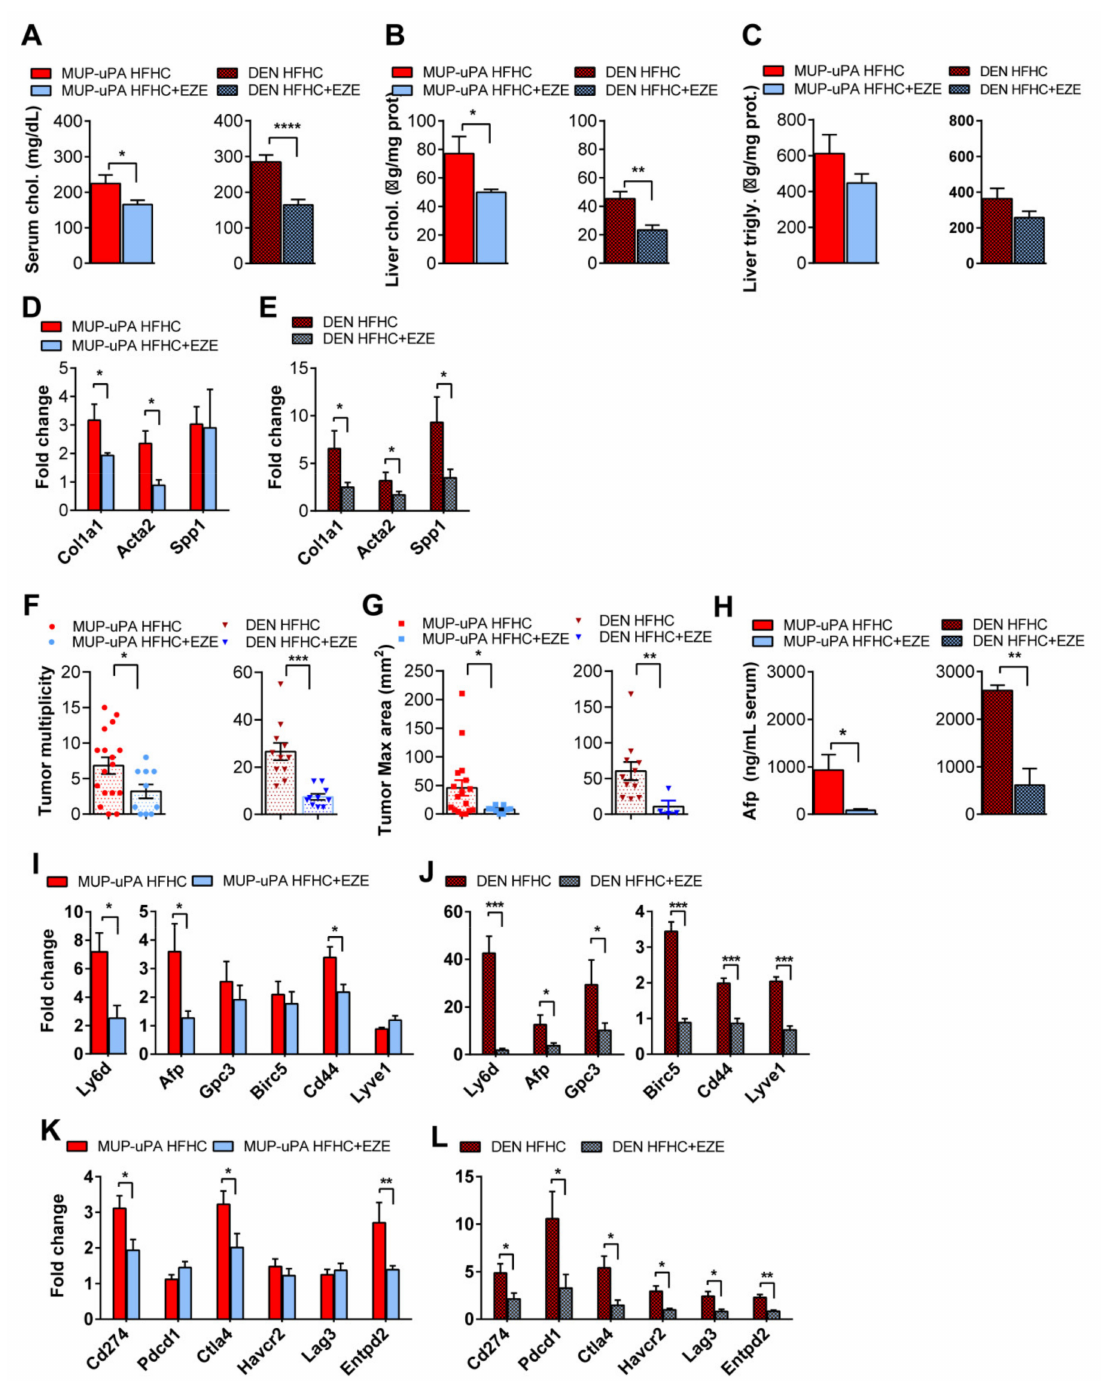
Figure 6. MUP-uPA or DEN-treated animals fed the HFHC diet supplemented with ezetimibe were compared to their corresponding HFHC-fed group. (UPA HFHC N = 17, UPA HFHC + EZE = 10; DEN HFHC n = 11, DEN HFHC + EZE = 11). ( A ) Serum total cholesterol levels in both models (MUP-uPA and DEN-treated) fed with the ezetimibe-supplemented diet. ( B ) Total cholesterol composition in liver tissue homogenates. ( C ) Triglyceride composition in liver tissue homogenates. ( D ) Expression levels of fibrogenesis genes ( Col1a1 , Acta2 , and Spp1 ) in MUP-uPA mice. N = 6 per group. ( E ) Expression levels of fibrogenesis genes ( Col1a1 , Acta2 , and Spp1 ). N = 6 per group. ( F ) Macroscopic tumor number in both models (MUP-uPA and DEN-treated) fed with the ezetimibe-supplemented diet, compared to their corresponding HFHC-fed group. ( G ) Maximum tumor size. ( H ) Serum Afp levels. ( N = 6–9 per group). ( I , J ) Transcript qPCR quantification of HCC-associated markers ( Ly6d , Afp , Gpc3 , Birc5 , Cd44 , and Lyve1 ) that showed a significant change in either model (MUP-uPA or DEN-treated). N = 6 per group. ( K , L ) Liver mRNA expression of the immune checkpoint and